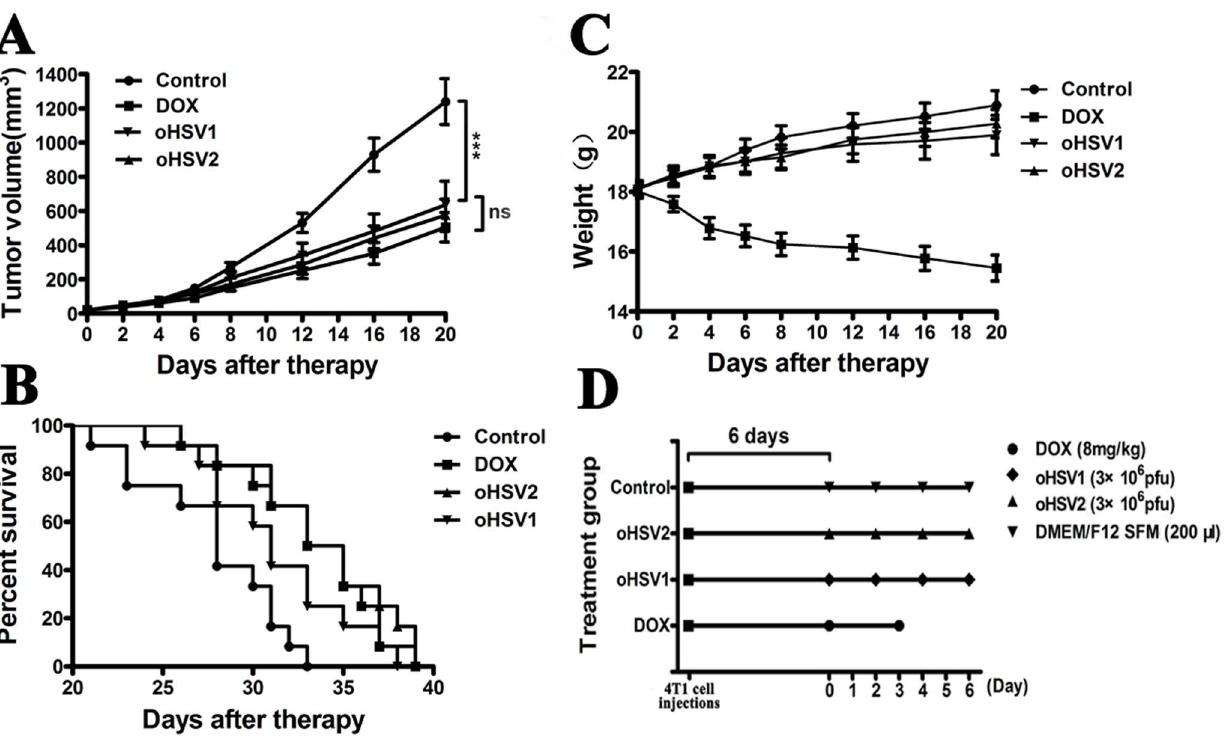
Figure 6. Anticancer effect of DOX, oHSV1 and oHSV2 in 4T1 breast tumors. The mice bearing 4T1 tumors were treated with DOX, oHSV1 or oHSV2 as described in the Materials and Methods section. A ) The tumor volume was measured every 4 days following treatments. The data are presented as the mean 6 SEM (n=12), p , 0.001. B ) The median survival times for the 3 groups are illustrated in Kaplan–Meier survival curves (n=12). Median survival: Control, 28 days; DOX, 34 days, p=0.0034; oHSV2, 34 days, p=0.0009; and oHSV1, 31 days, p=0.0043. C ) The weight of the mice was measured every 4 days following treatments. The data are presented as the mean 6 SEM (n=12). ***, p , 0.001 and ns, no significant differences. D) Schematic of the experimental design. Each spot represents one